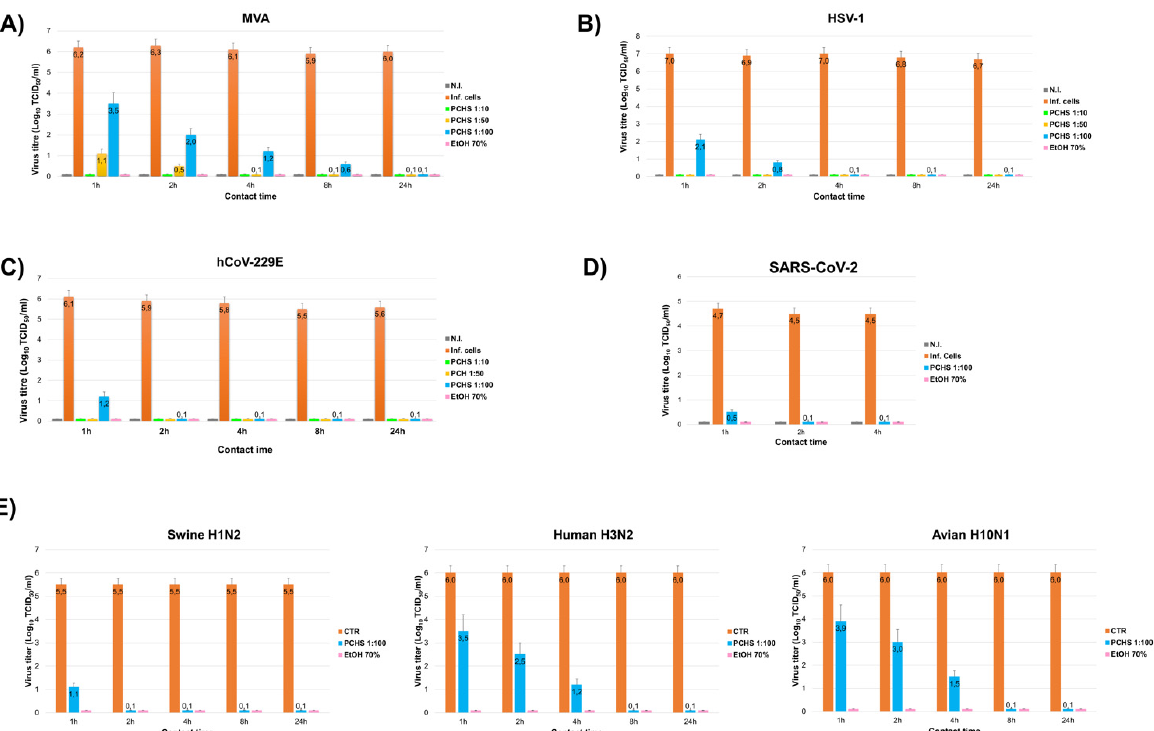
Figure 1. PCHS antiviral activity in suspension tests performed on the indicated enveloped viruses. ( A ) modified Vaccinia virus (MVA) virus titre after contact with PCHS at the indicated dilutions, as measured in BHK target cells. ( B ) HSV-1 virus titre after contact with PCHS at the indicated dilutions, as measured in target Vero cells. ( C ) hCoV-229E virus titre after contact with PCHS at the indicated dilutions, as measured in MRC-5 target cells. ( D ) SARS-CoV-2 virus titre after contact with PCHS (dilution 1:100), as measured in Vero target cells. ( E ) human and animal influenza virus titres after contact with 1:100-diluted PCHS, as measured in swine H1N2, human H3N2 and avian H10N1 strains were used, and residual virus titre was measured in MDCK target cells. Positive control of virus inactivation was represented by 70% EtOH in each assay. Results are expressed as Log 10 TCID 50 / mL , and represent the mean ± SD values of duplicate samples from three independent assays for each virus type.